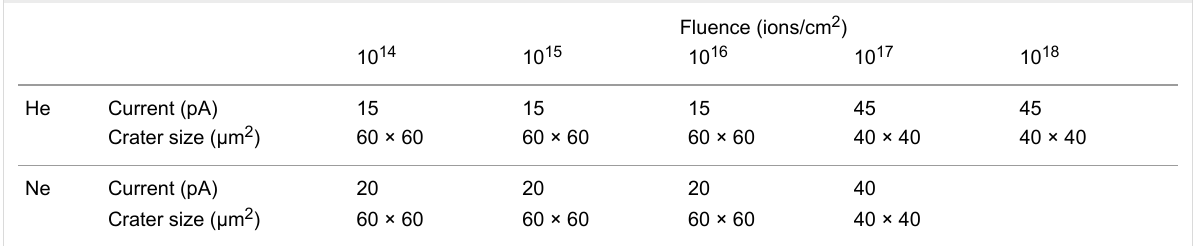
Table 2: Experimental conditions for He + and Ne + irradiation on the HIM. Irradiation time is calculated based on primary ion current and changes of the latter during ion